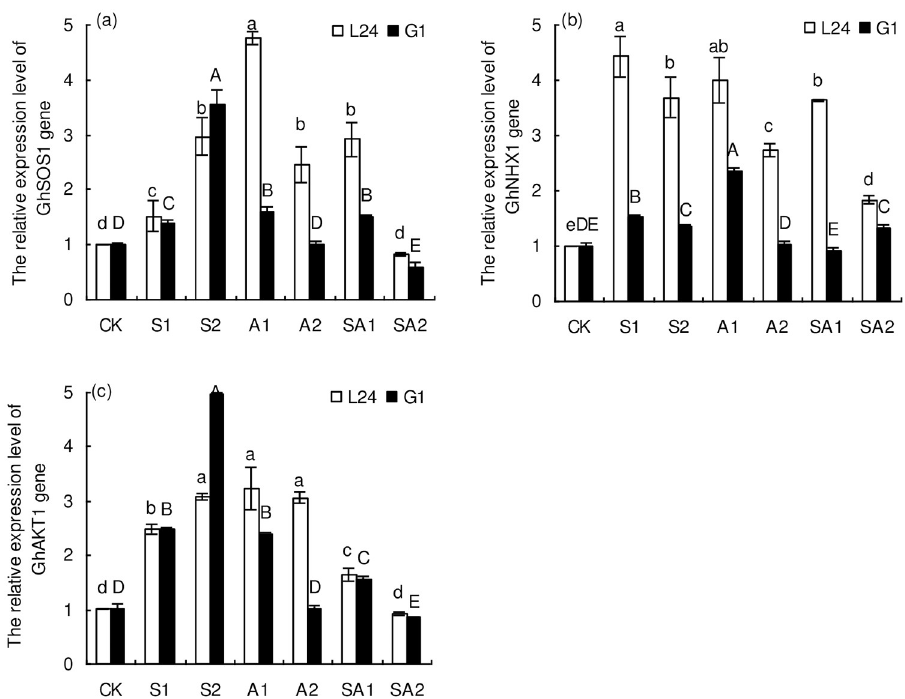
Fig 8. Relative expression of GhSOS 1 (a), GhNHX 1 (b) and GhAKT 1 (c) genes of two cotton varieties (salt-tolerant variety L24, salt-sensitive variety G1) under different salt stresses. Symbols indicate L24 cultivar (white bar) and G1 cultivar (black bar). Vertical bars represent ± standard error (n = 4). Bars labeled with the different lowercase letters or uppercase letters are significantly different ( P < 0.05) among different saline and alkaline stress treatments.